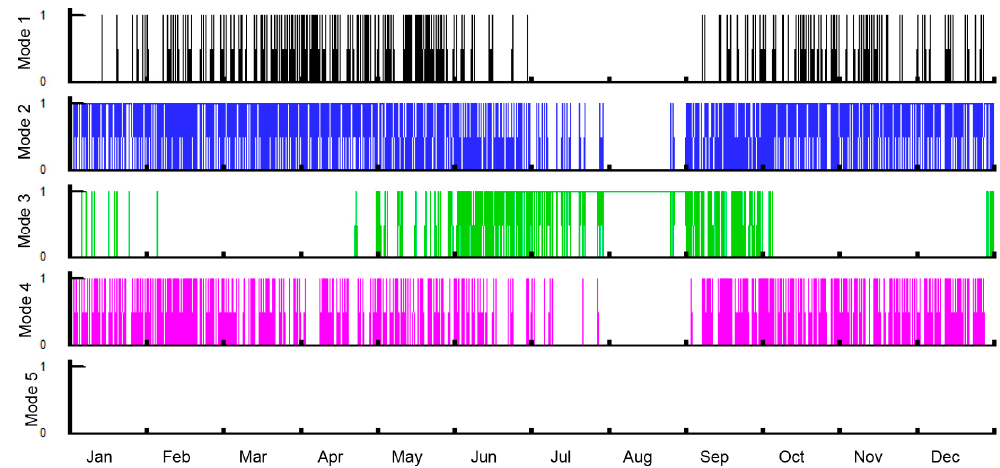
Figure 5. Operating modes of the DeReC system during a reference year.